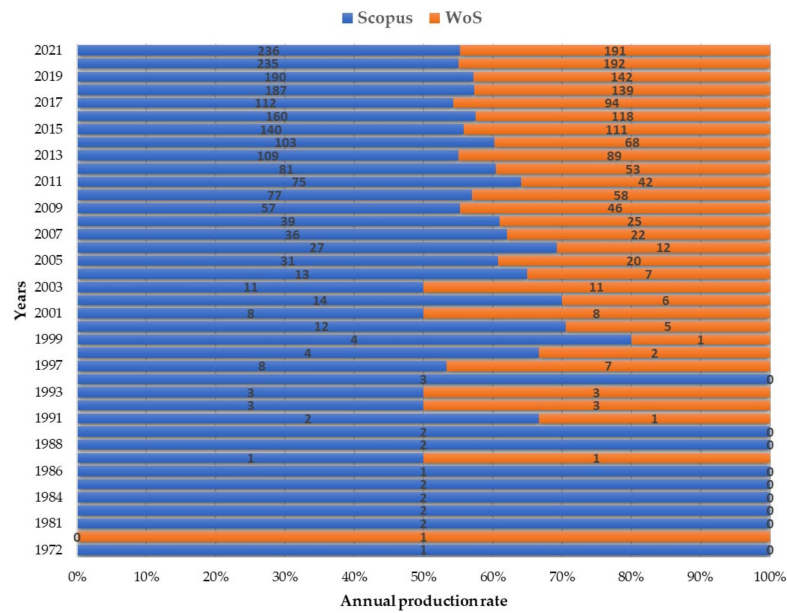
Figure 3. Contribution of databases (Scopus and